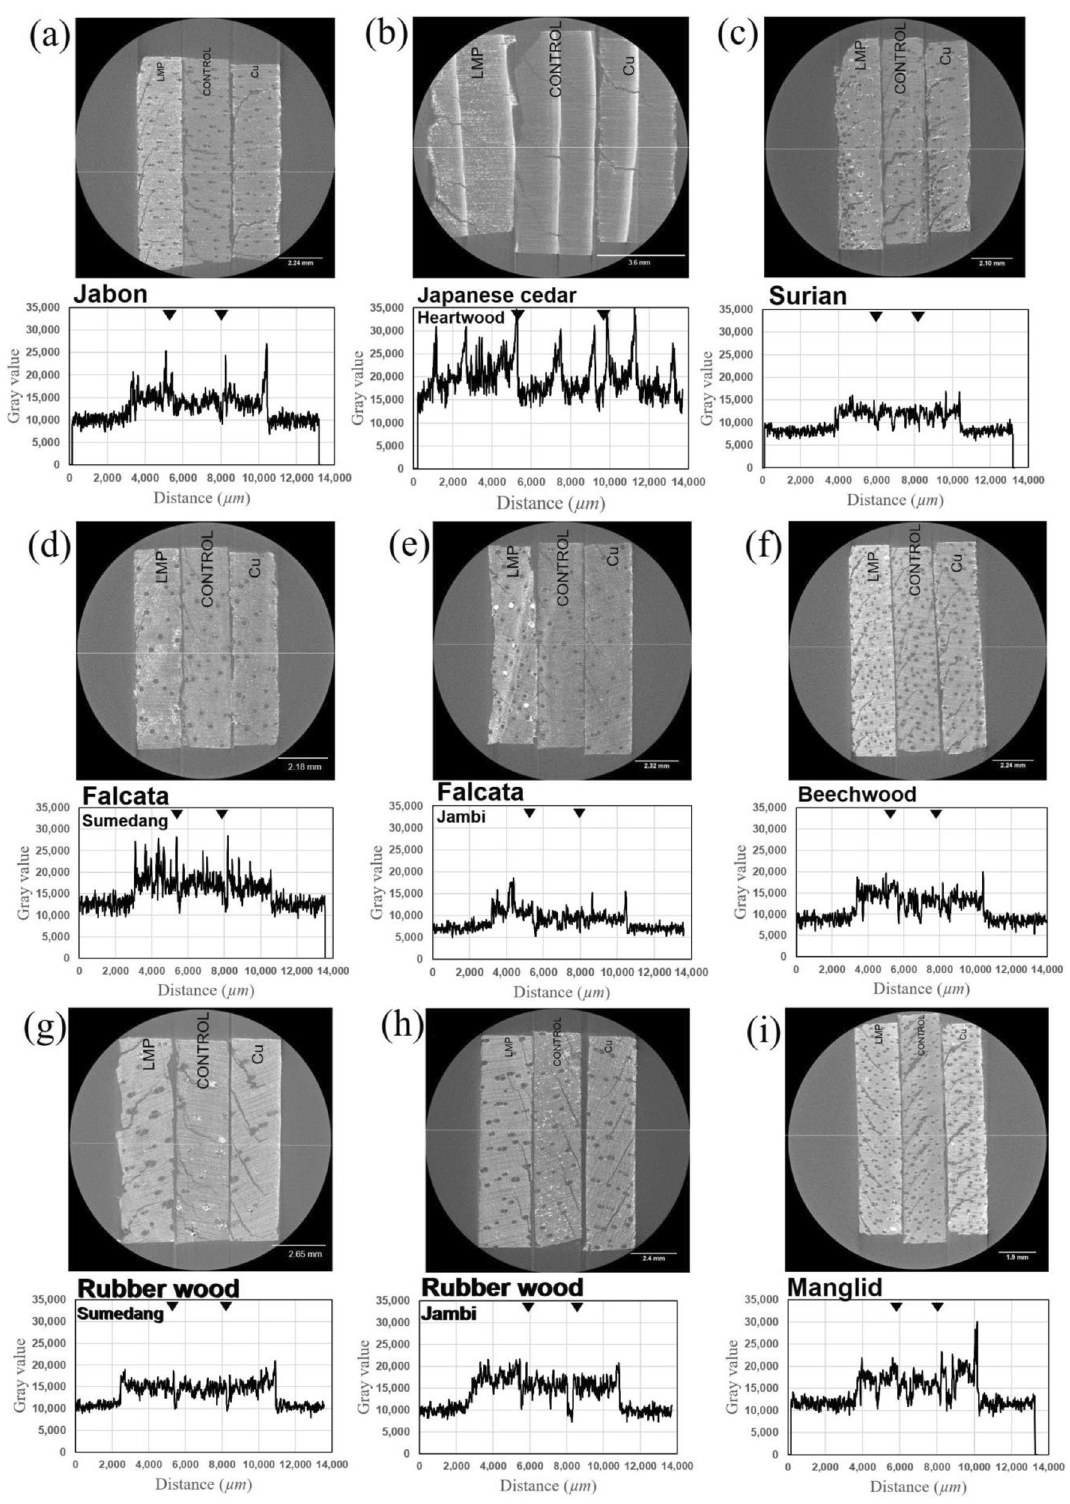
Figure 4. The 2D X-ray visualization of various woods. ( a ) Jabon wood from Sumedang city, ( b ) Japanese cedar heartwood veneer, ( c ) Surian wood, ( d ) Falcata wood from Sumedang city, ( e ) Falcata wood from Jambi city, ( f ) Beechwood, ( g ) Rubber wood from Sumedang city, ( h ) Rubber wood from Jambi city, and ( i ) Manglid wood, including the image gray value of the yellow middle